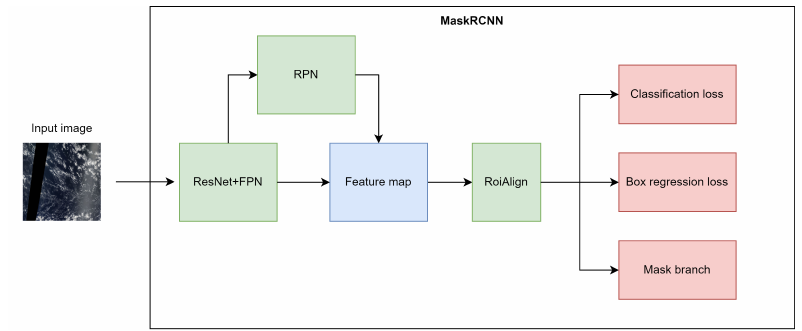
Figure 9. MaskRCNN: two-stage object instance segmentation neural network.